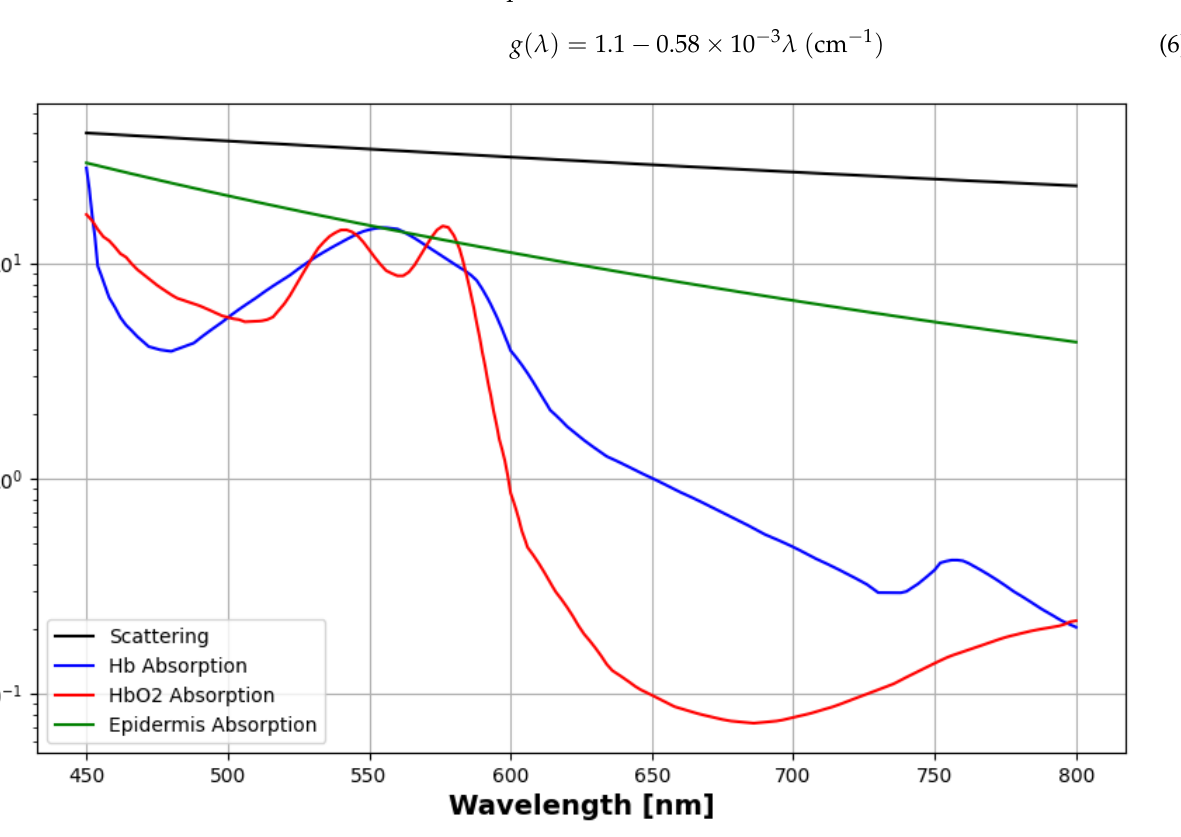
Figure 2. Scattering and absorption coefficients for the skin model used in this